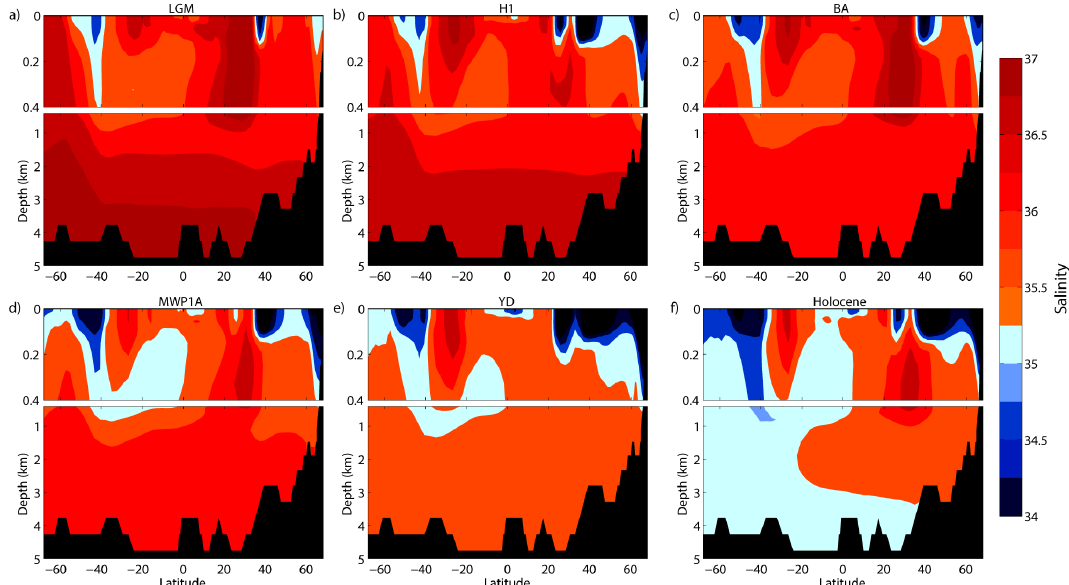
Figure 6. TraCE-21K salinity meridional sections across the Atlantic Ocean (25 ◦ W) at (a) LGM (22ka–19ka); (b) H1 (19ka–14.67ka); (c) BA (14.67ka–14.35ka); (d) MWP-1A (14.35ka–13.85ka); (e) YD (12.9ka–11.3ka); (f) Holocene (11.3ka–0ka).